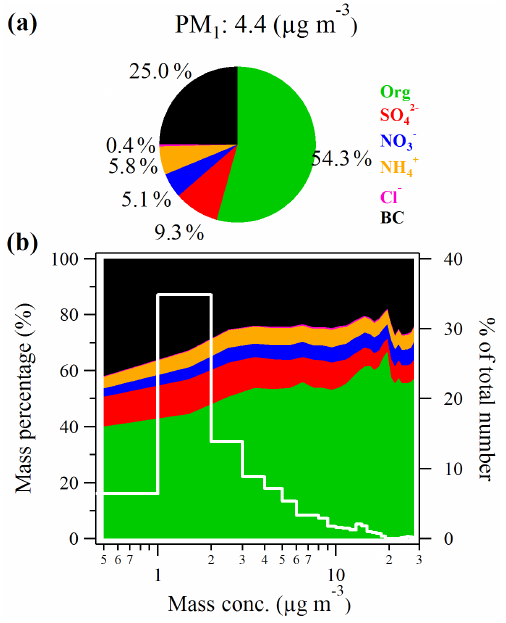
Figure 3. The average mass contributions of PM 1 (calculated by NR-PM 1 + BC) species (a) during the entire sampling period and (b) as a function of the total PM 1 mass concentrations. The white solid line in (b) shows the percentage of the data number in each mass bin to the total data